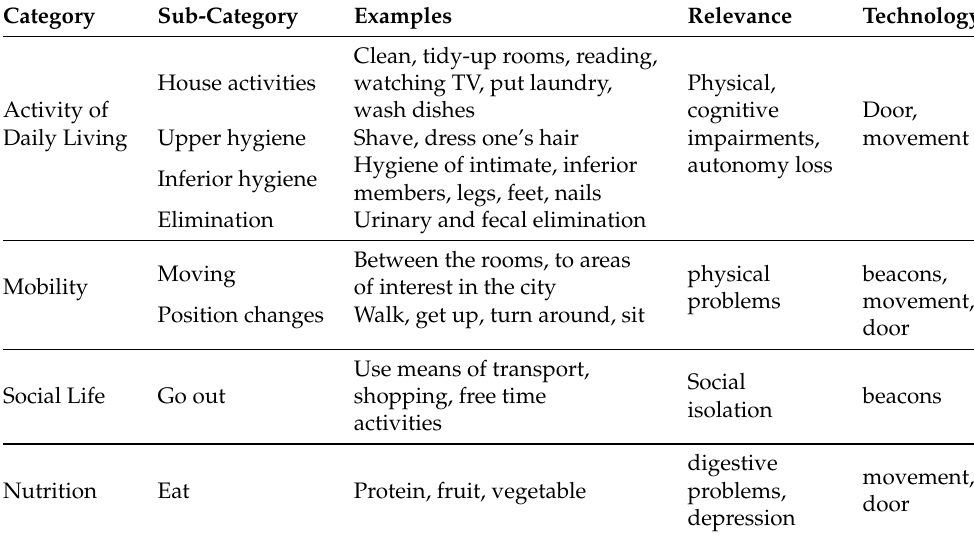
Table 4. Low Elementary Actions’ categories.